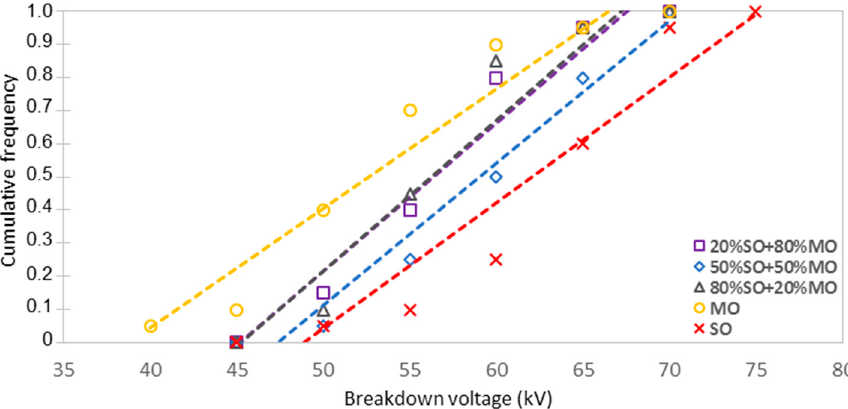
Figure 17. Linear trend of the cumulative frequency of DC breakdown voltage of mineral oil and synthetic ester